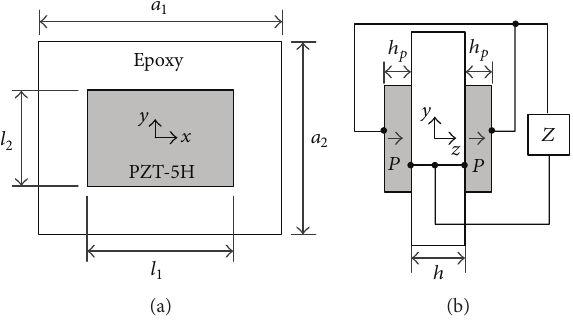
Figure 1: Unit cell of the two-dimensional PPC-C of orthogonal lattice: (a) top view and (b) side view.